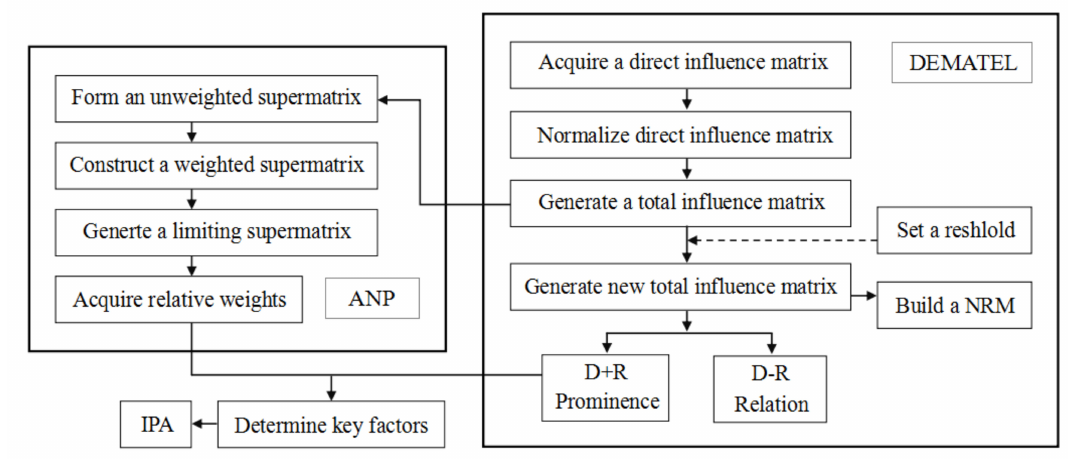
Figure 1. DANP framework. ANP—Analytic Network Process; DEMATEL—Decision Making and Trial Evaluation Laboratory; IPA—importance–performance analysis; NRM—Network Relationship